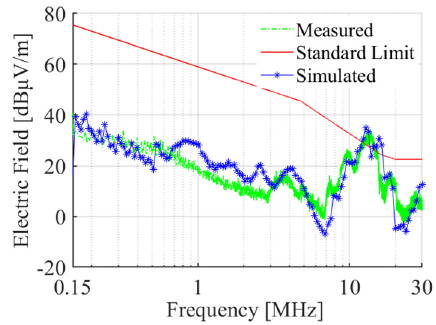
Figure 10. Comparing result of electric field at left side.